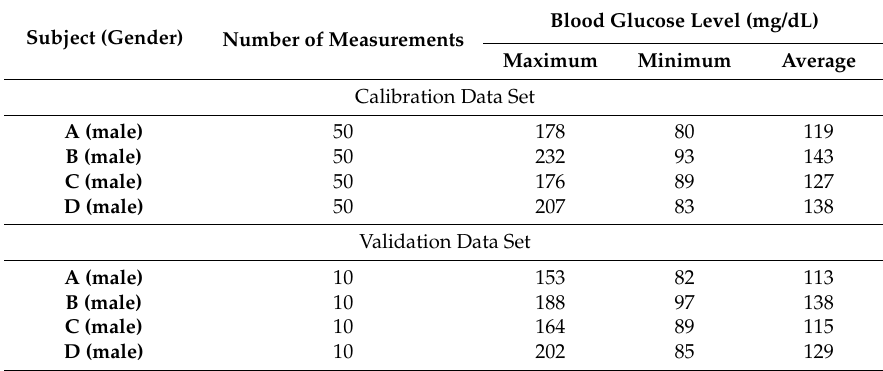
Table 1. Reference blood glucose data